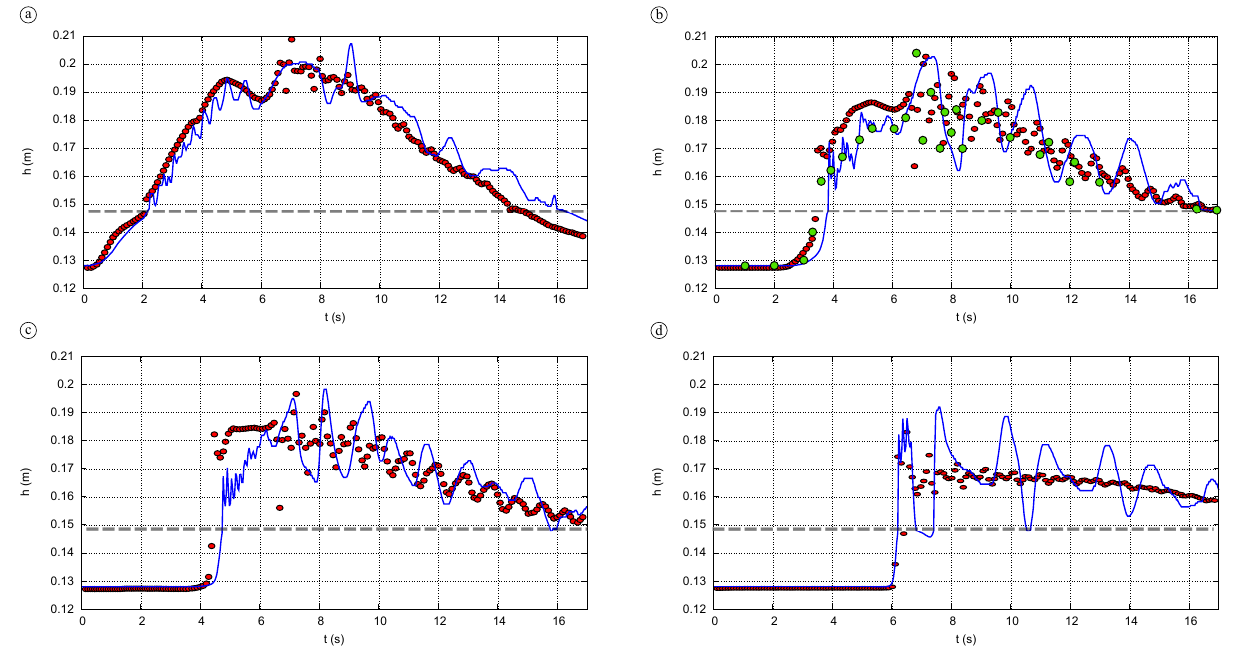
Figure 8. Comparision between numerical results (blue), experimental data (green dots) and numerical results from Kerger et al. (2010) (red dots) for the four gauges of the Wiggert test case setup.